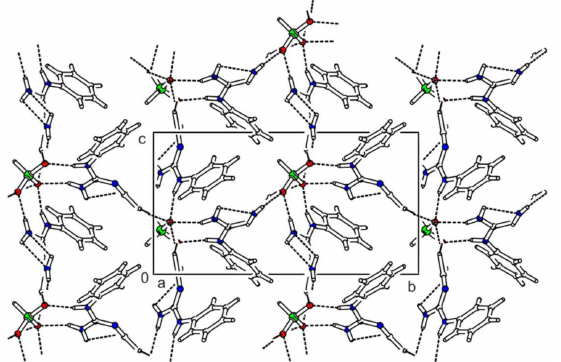
Figure 6. Packing scheme of phbigua 2 HPO 3 (view along the a axis direction); dashed lines indicate hydrogen bonds, solid lines indicate unit